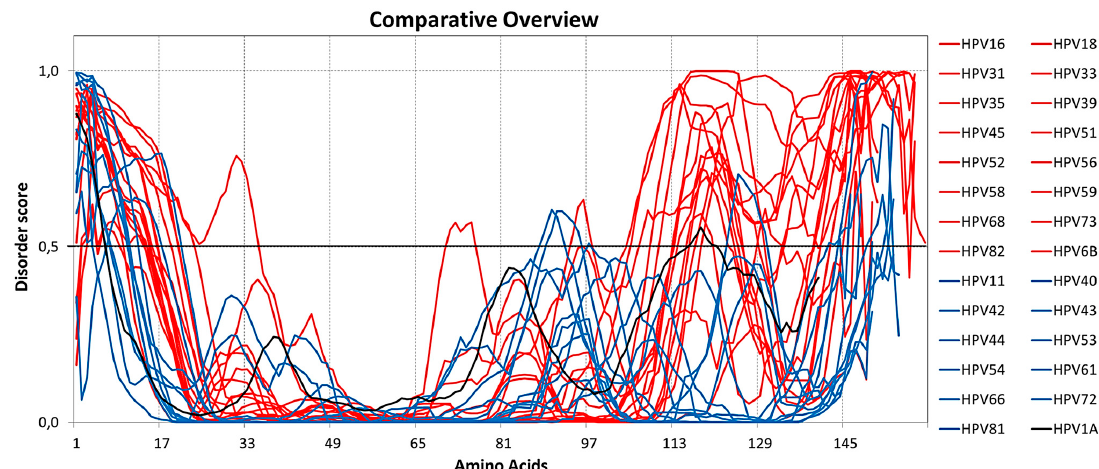
Figure 1. Intrinsic disorder analysis of E6 proteins of high and low-risk human papillomavirus (HPVs), oncogenic and control. The dashed lines at 0.5 of y -axis are threshold lines for disordered/structured residues. Residues with a score above this line are predicted disordered, and residues with a score below 0.5 are predicted to be ordered. Intrinsic disorder of HPV E6 proteins of high-risk (red), low-risk (blue), and control (black) are shown.